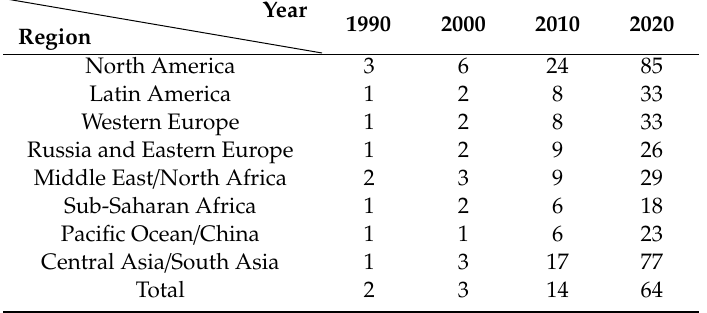
Figure 13. The screw generator set of Buluan biomass power plant in the Philippines.